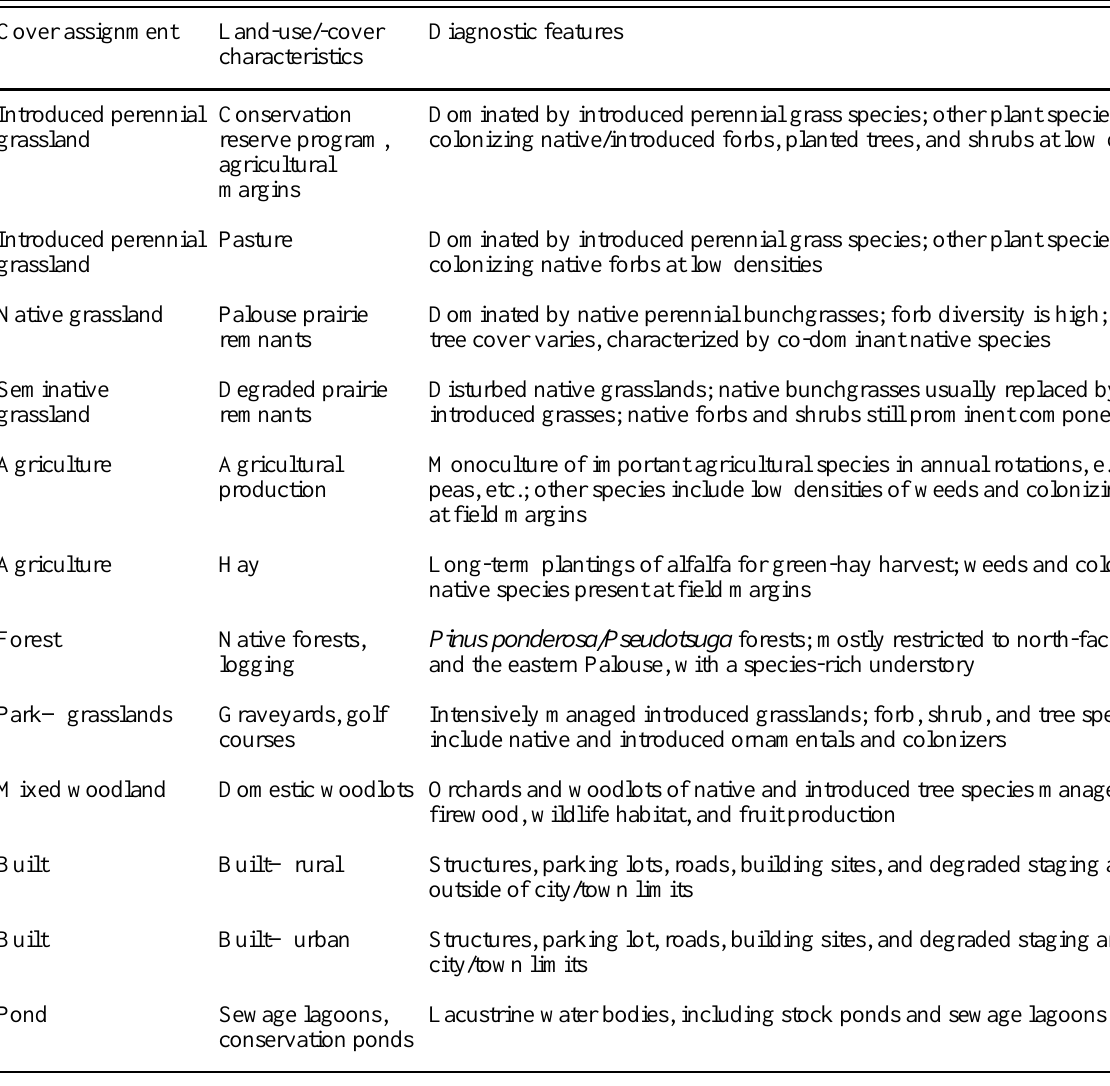
Table 1 . Land-cover classes and defining characteristics. Cover